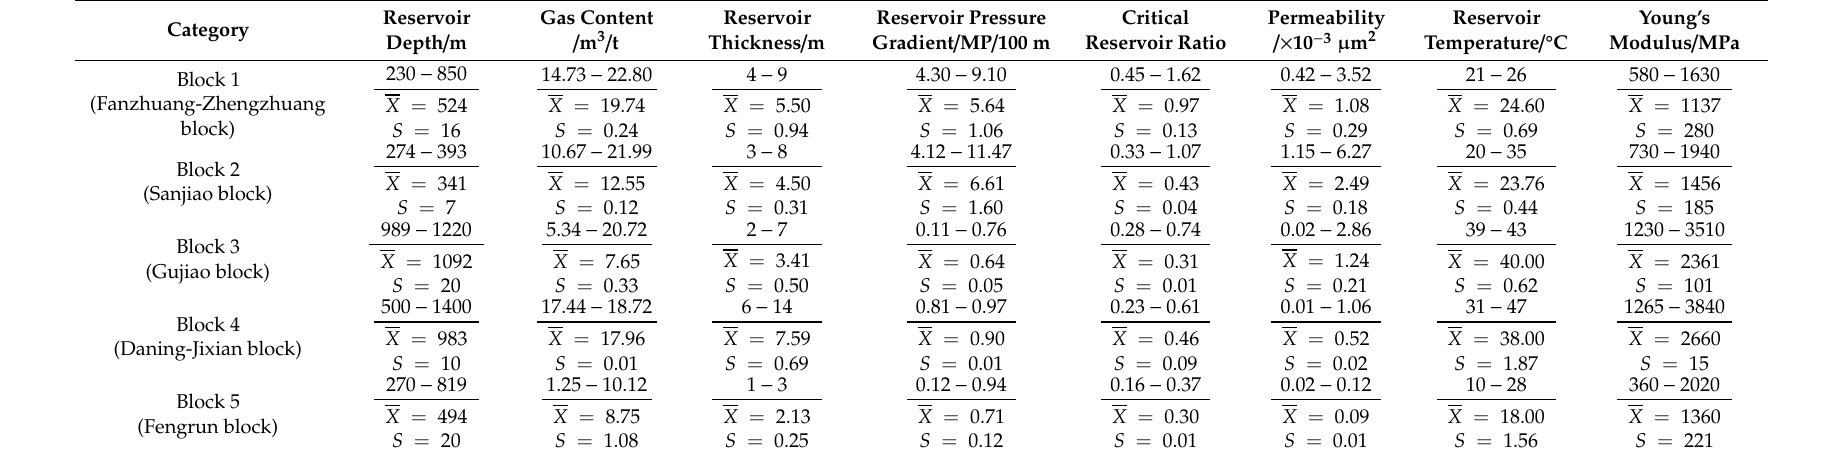
Table 1. Coalbed methane (CBM) target blocks development evaluation parameter